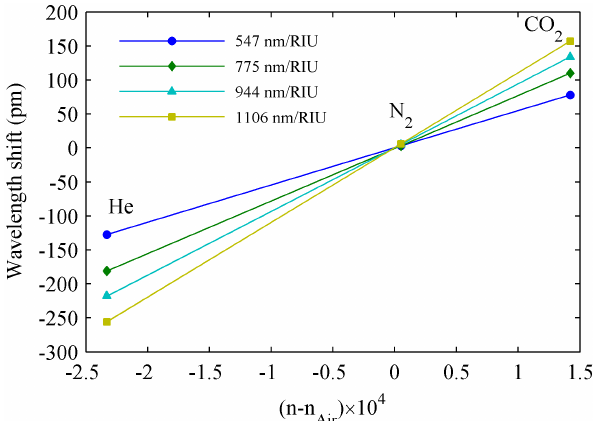
Figure 8. The wavelength shift as a function of the refractive in- dex. The results are for cavities corresponding to band gaps a (cir- cle), b (diamond), c (triangle), and d (square). The cavity length has been adjusted so that all cavities operate at a central wavelength of 1.55µm, d cavity = 0 . 85µm for a and d cavity = 0 . 75µm for b , c , and d .